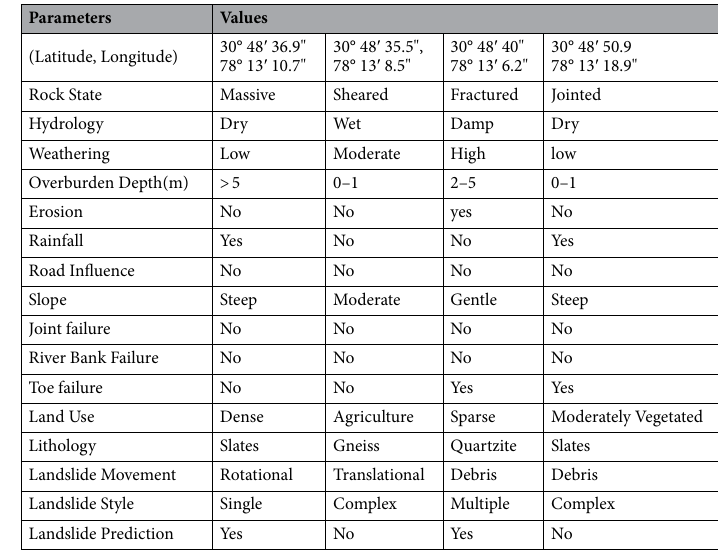
Table 1. Landslide Inventory sample of the study area (Uttarkashi district) obtained based on field investigation that is publicly available on GSI landslide reports 19–21 .